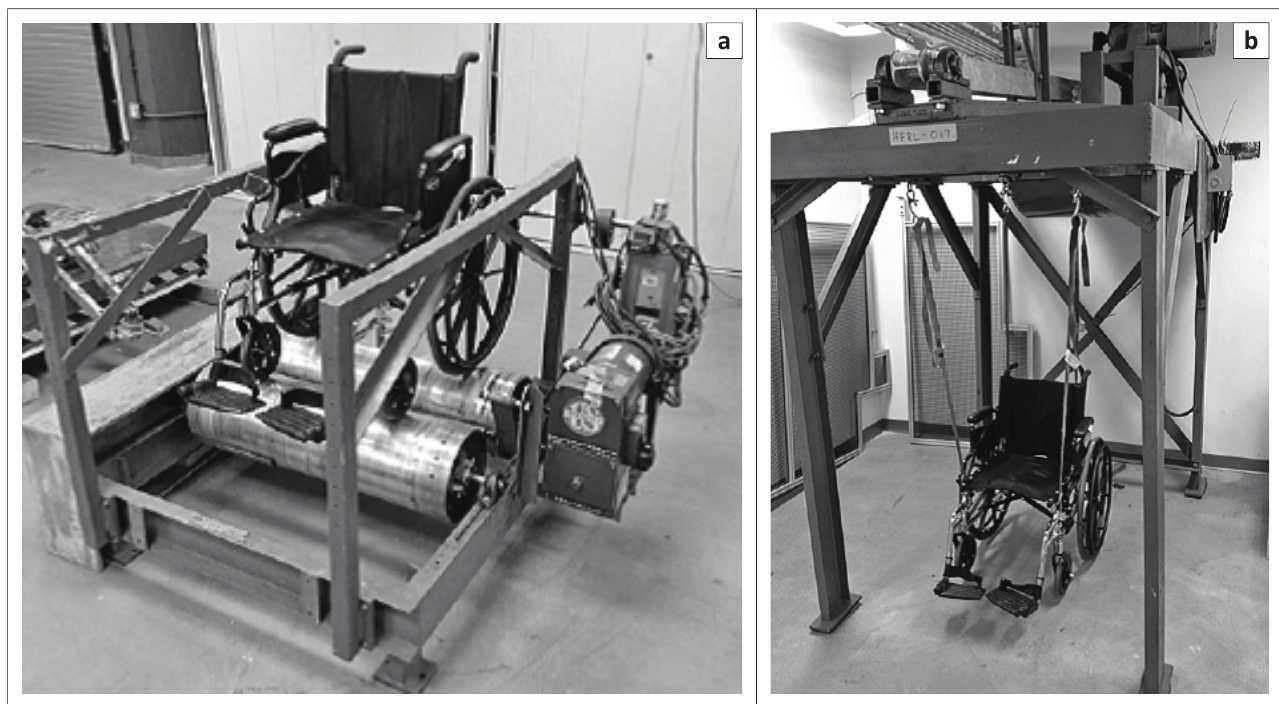
FIGURE 3: Multidrum test (left) and curb-drop test (right) without test